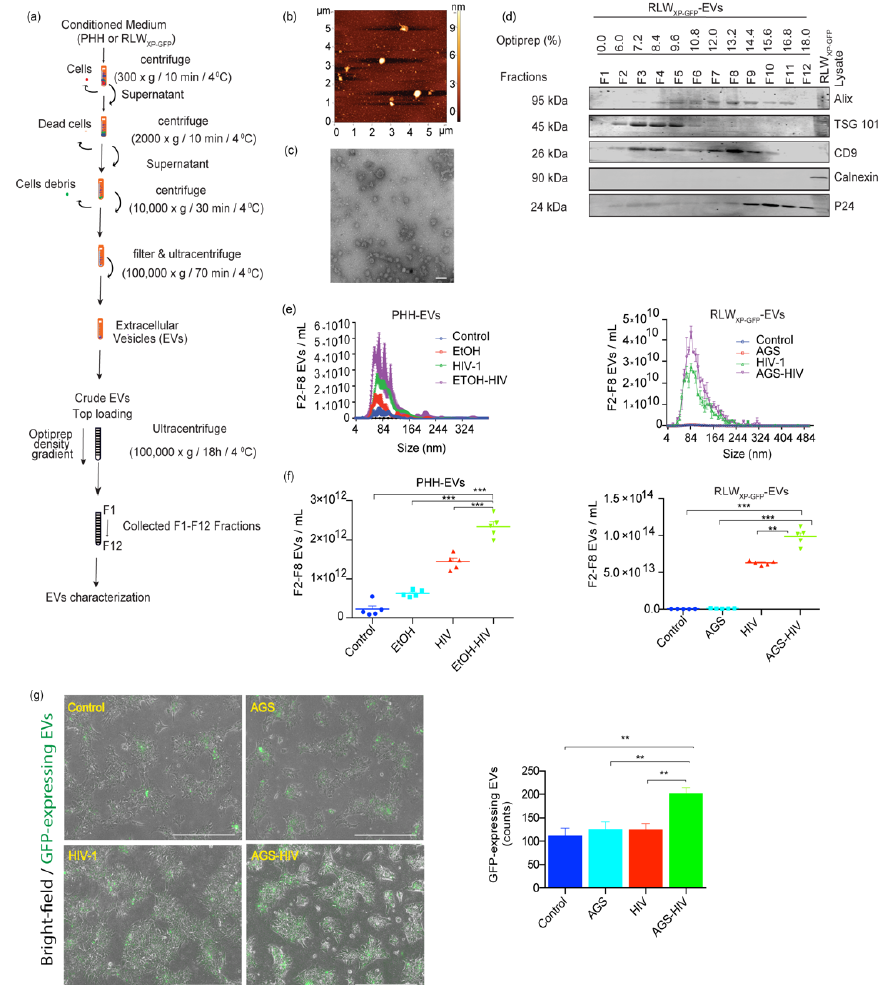
Figure 1. Ethanol (EtOH) stimulates EV release from HIV-infected hepatocytes. ( a ) Schematic demonstration of the process of extracellular vesicles (EVs) separation and OptiPrep density gradient method. ( b ) Topographic profiling of EVs, using atomic force microscopy (AFM) reveals a heterogeneous population of spherical particles of RLW XP-GFP cells. ( c ) Transmis- sion electron microscopy of EVs derived from acetaldehyde-generating system (AGS)–HIV-infected RLW cells reveals a heterogeneous population of small EVs (<200 nm). Magnification 110,000 x and scale bar 100 nm. ( d ) Representative im- munoblotting images from AGS–HIV treated group show protein expression from F1-F12 fraction of EVs and RLW XP-GFP cells lysate for EV-associated proteins ALIX, TSG101, and CD9, small extracellular vesicle (sEV) negative marker calnexin, and HIV protein p24 enrichment in fractions F9-F12. ( e ) The size distribution of pooled EVs from F2–F8 fractions, released from primary human hepatocytes (PHH) EVs and RLW XP-GFP -EV by NanoSight and ZetaView, respectively. ( f ) Dot plots show the concentration of EVs released from EtOH treated HIV-infected PHH and acetaldehyde-generating system (AGS)- treated HIV-infected RLW XP-GFP cells EV by NanoSight and ZetaView, respectively. ( g ) AGS–HIV treatment in RLW XP-GFP cells induces more endogenous EVs, as compared to their respective controls. The bar graph shows quantification of EVs with Fiji software by counting GFP expressing EVs from five to nine randomly captured images with a fluorescence mi- croscope at 10x magnification. Results represent the mean ± SEM. ( e – g ) Statistical significance between groups is indicated by asterisk(s) and determined by one-way ANOVA (*** p ≤ 0.001 and ** p ≤ 0.01).